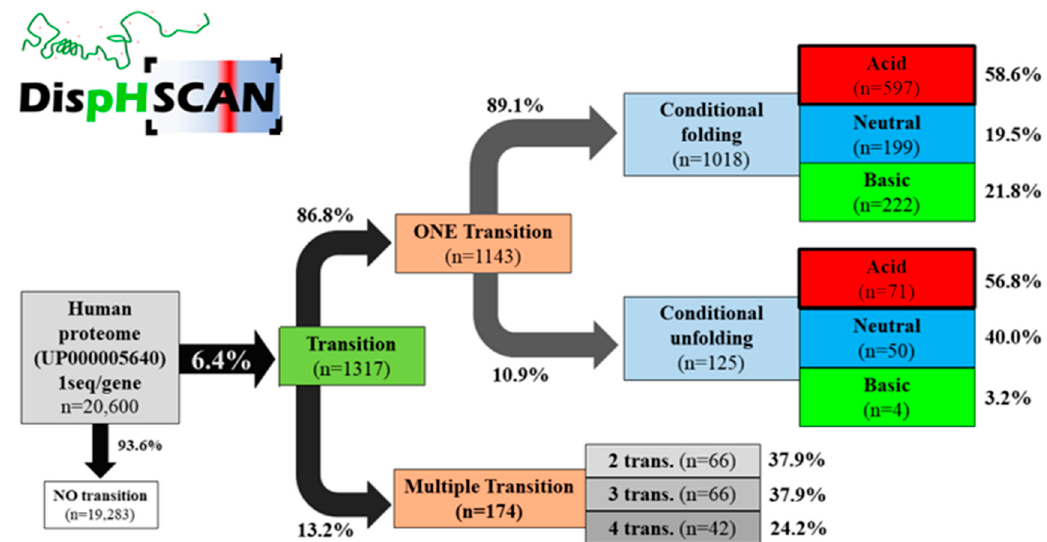
Figure 2. DispHScan statistics on the human proteome. Proteins were classified based on whether they experiment no-, single- or multiple-transitions. Protein switches from disordered states at lower pH to ordered states at higher pH were defined as conditional folding, whereas the reverse transition was defined as conditional unfolding. Depending on the specific pH at which the folding/unfolding transition occurs, they were named acid (<6), neutral (6–8), or basic